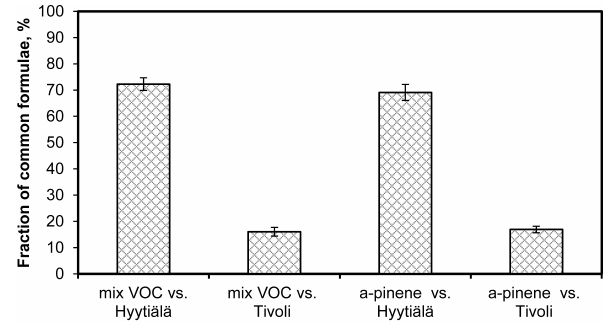
Fig. 6. Fraction of molecular formulae below 300Da found in SOA from both laboratory-generated and ambient samples relative to the total number of formulae in the ambient samples. The error bars represent the standard deviation of three replicate chamber experi- ments.